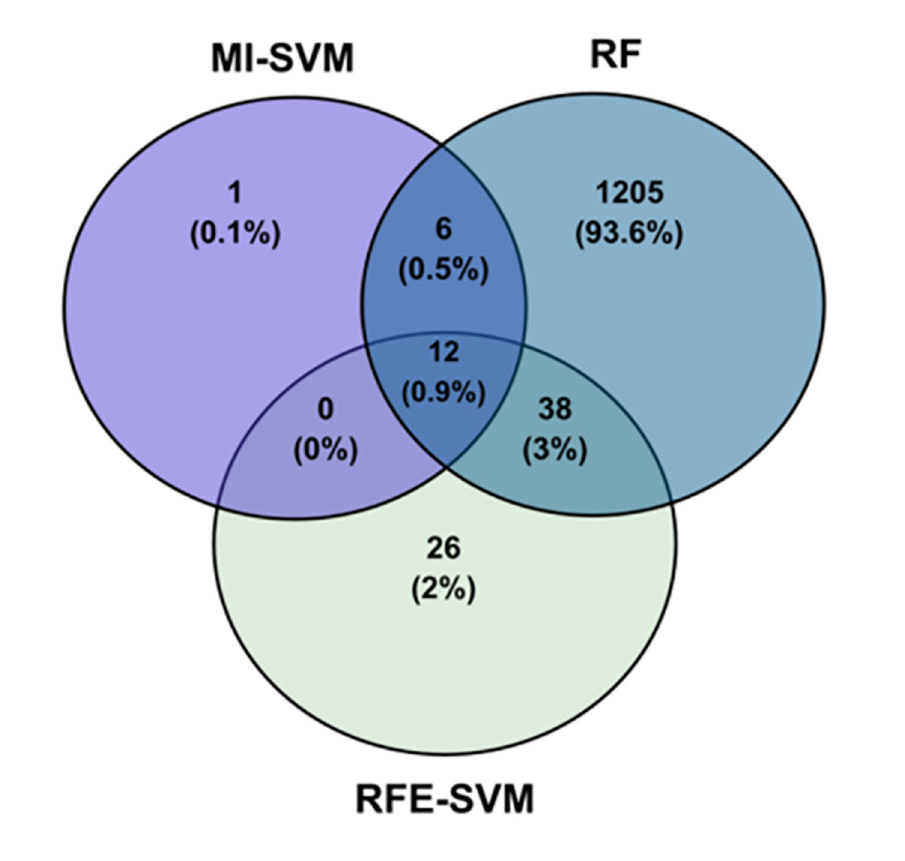
Fig 4. A Venn diagram illustrating the number of features of each model and the common features across all techniques.